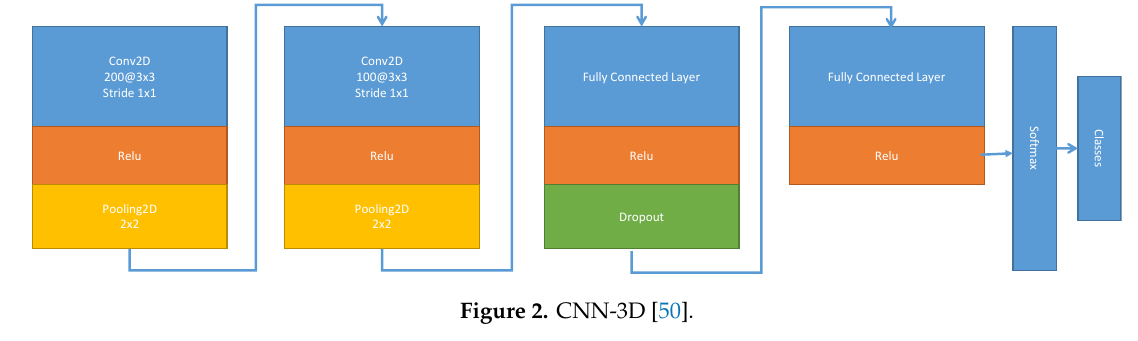
Figure 2. CNN-3D [50]. Figure 2. CNN-3D